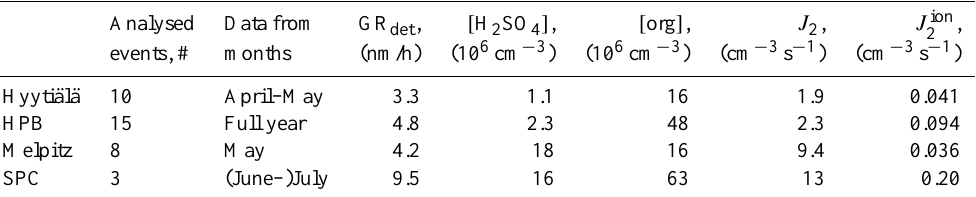
as a sum of J + and J − are calculated from the data points measured during 2 2 2